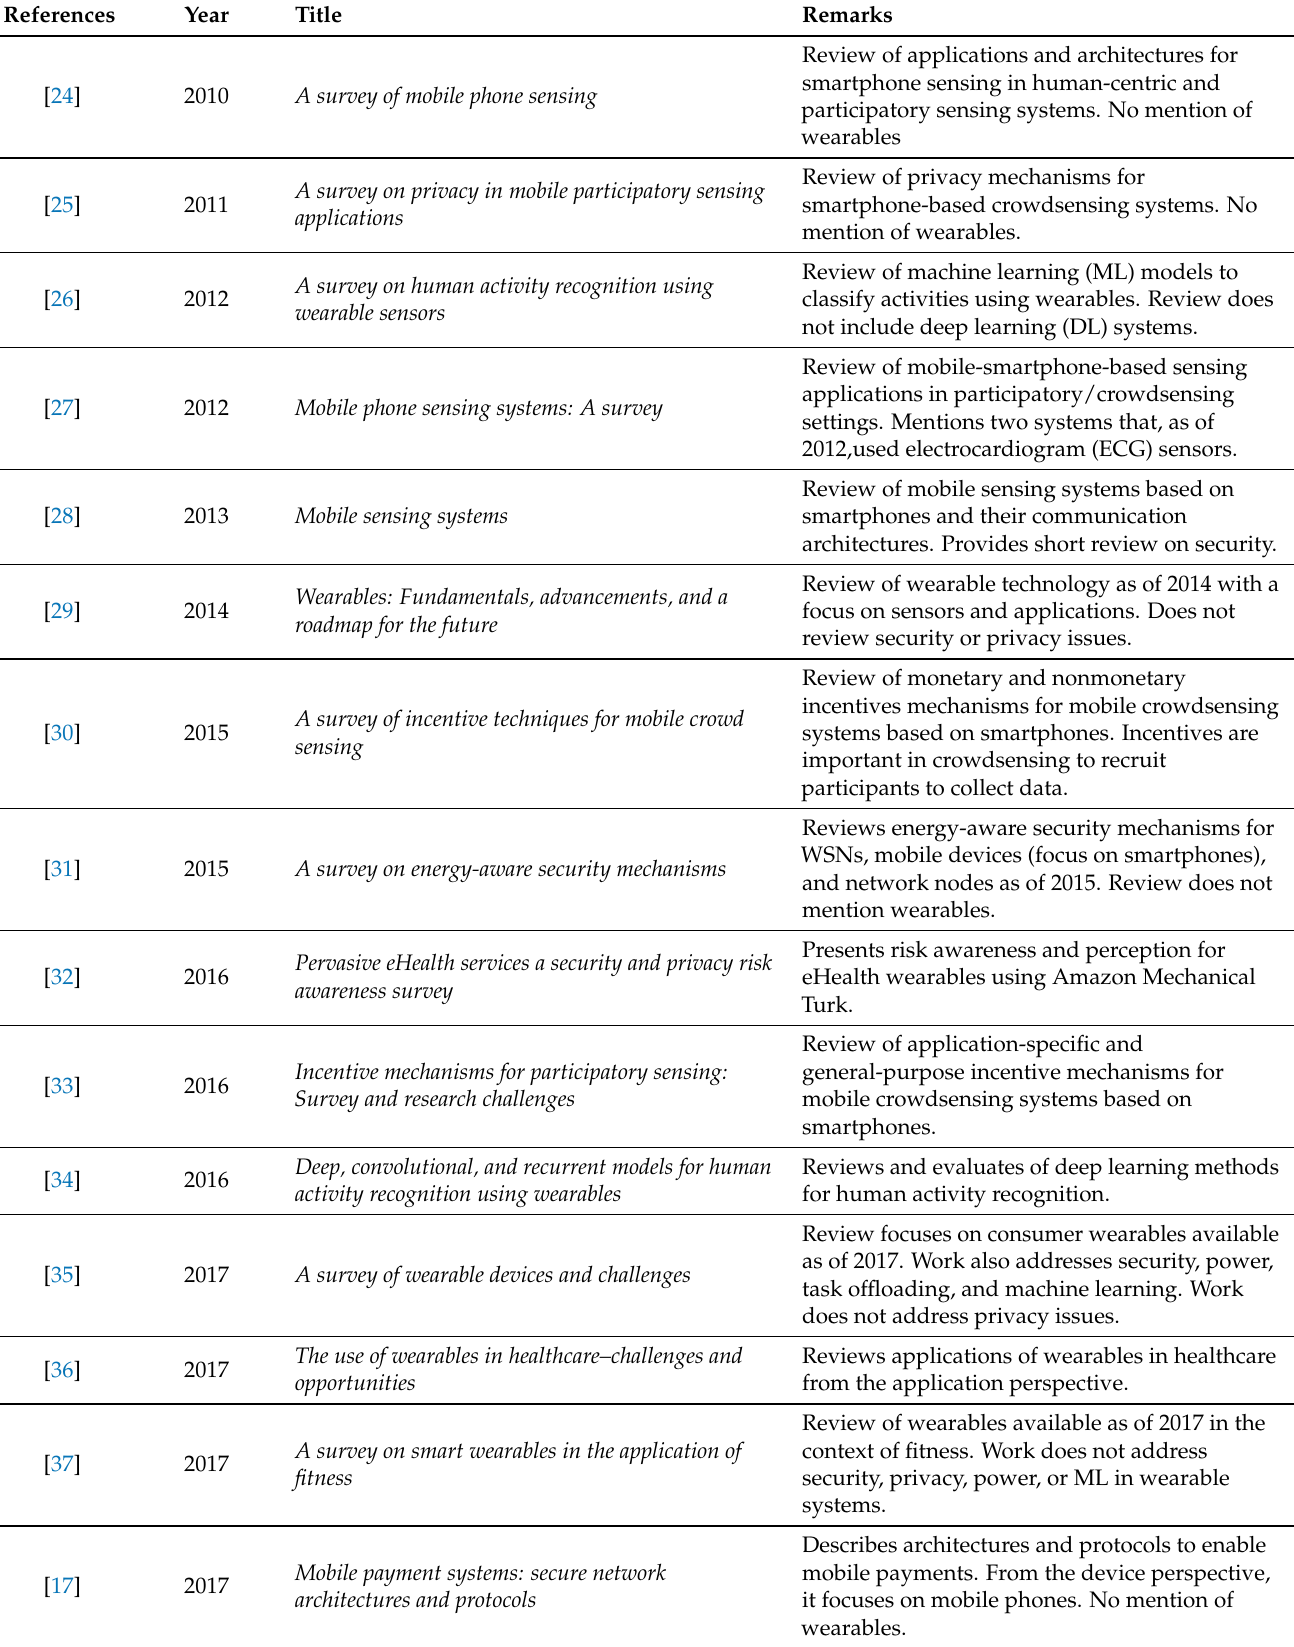
Table 1. Summary of survey works in mobile and wearable